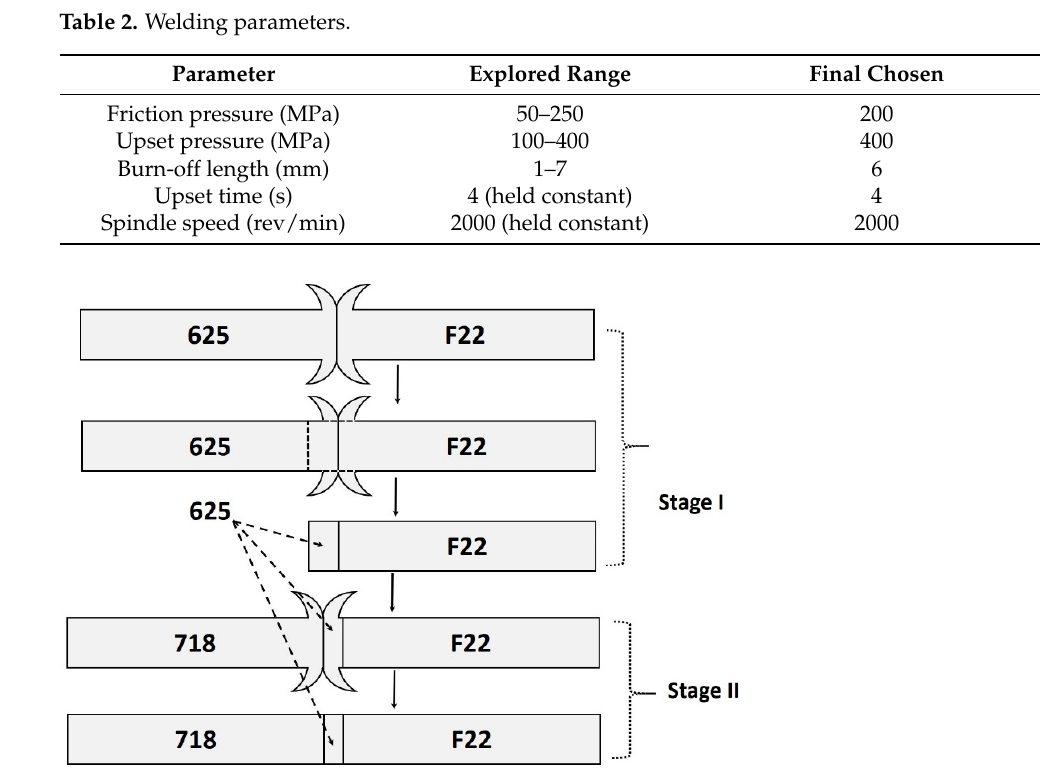
Figure 1. Schematic diagram showing the steps during the preparation of the Inconel 718/F22 friction weld joint with Inconel 625 interlayer. Table 1. Chemical composition (wt%) of the Inconel 718, Inconel 625, and F22.